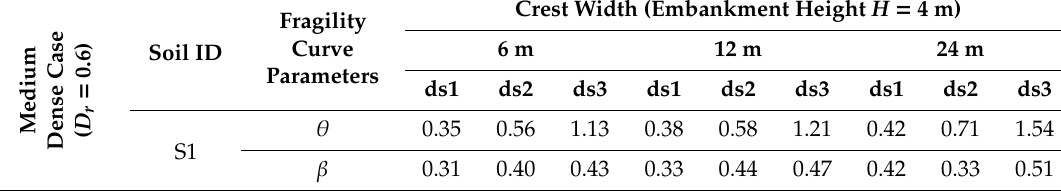
Table 4. Fragility curve (FC) parameters for di ff erent crest widths (medium dense soil, peak ground acceleration (PGA), road